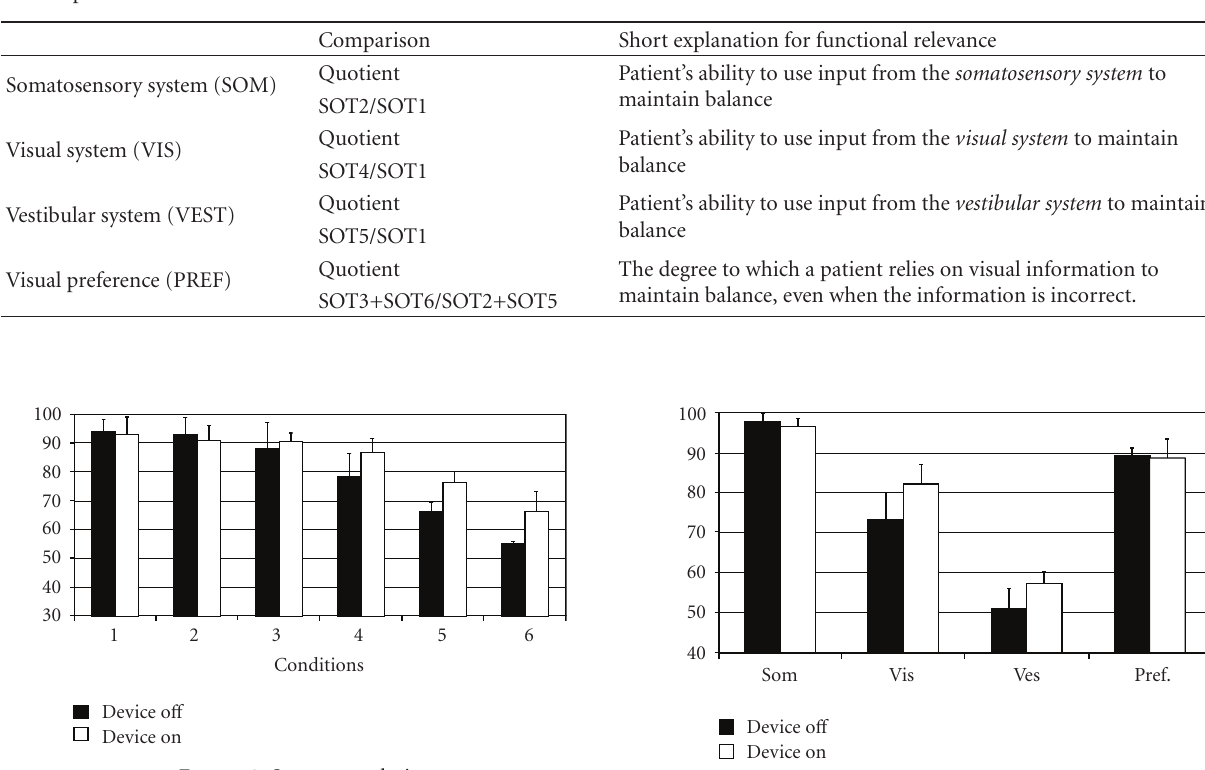
Table 1: Algorithms for calculating the individual components of balance (visual, somatosensory, vestibular, and visual preference) and short explanation.